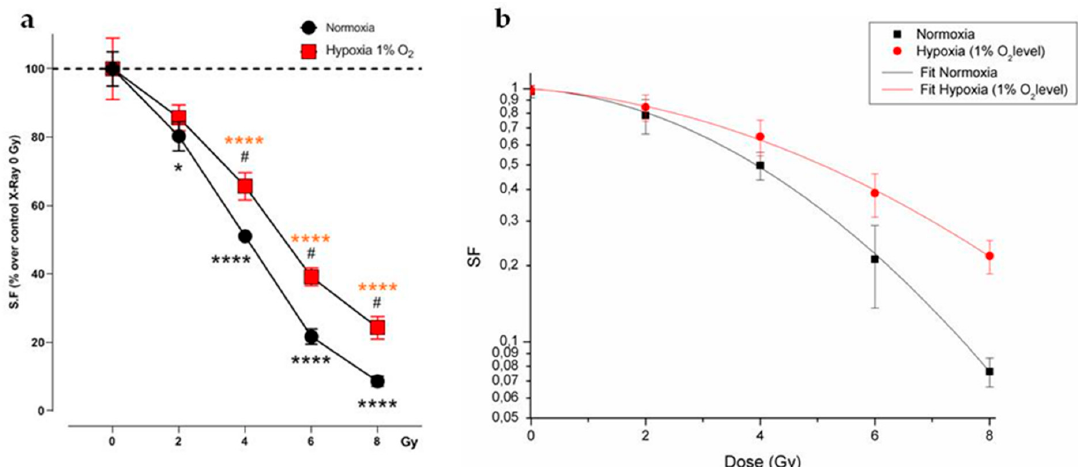
Figure 2. U251-MG irradiated cells in normoxia and hypoxia. ( a ) Surviving fraction (SF) plot of normoxic and hypoxic U251-MG cells exposed to 0, 2, 4, 6 and 8 Gy. Data are mean ± SEM of n = 3 independent experiments. * p -value < 0.05 and **** p -value < 0.0001 versus normoxia 0 Gy; # p -value < 0.05 versus each dose in normoxia (F Si306conc. = 133.8, p -value < 0.0001; F Gy = 15.49, p -value = 0.0003; F Si306conc. x Gy = 1.568, p -value = 0.1973. Two-way ANOVA with Holm–Šídák post-hoc test). ( b ) Linear-quadratic adjustment of the data of U251 cell survival curves treated with X-rays in hypoxia and normoxia.